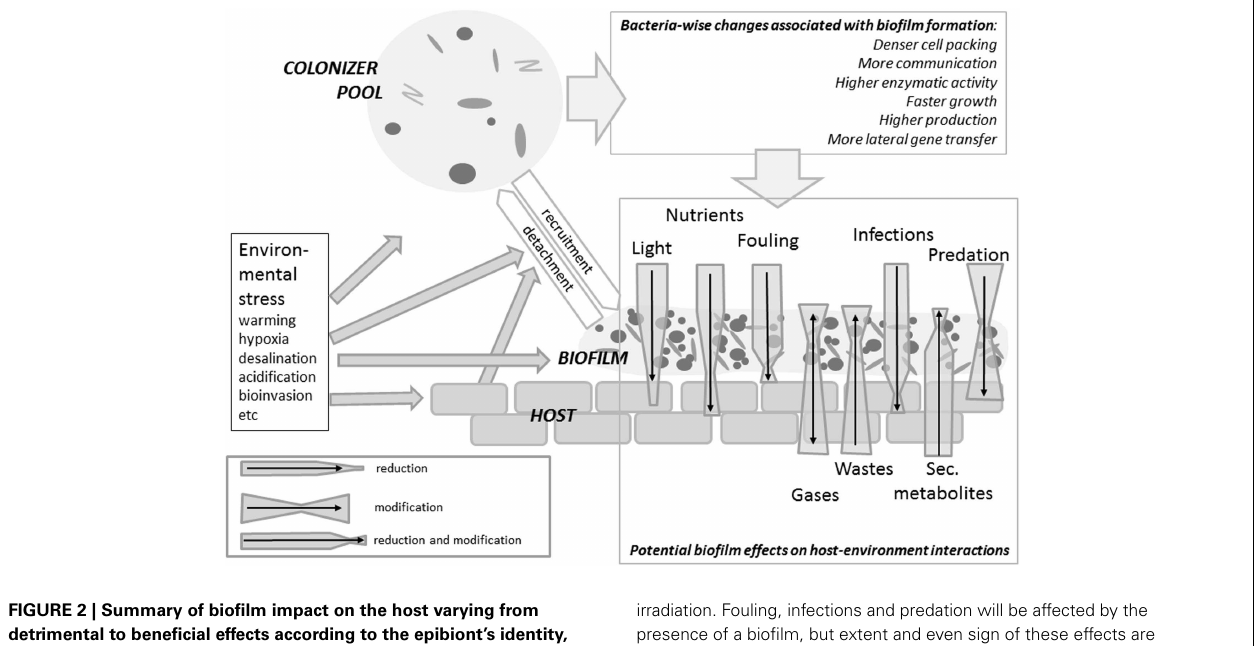
FIGURE 2 | Summary of biofilm impact on the host varying from detrimental to beneficial effects according to the epibiont’s identity, the type of interaction considered and the environmental conditions. Via a recruitment/detachment equilibrium – controlled by environmental and host traits – epibiotic bacterial communities are connected to the free water phase.When forming a biofilm, bacteria experience a boost in activity and interactions.The host will experience a certain reduction in